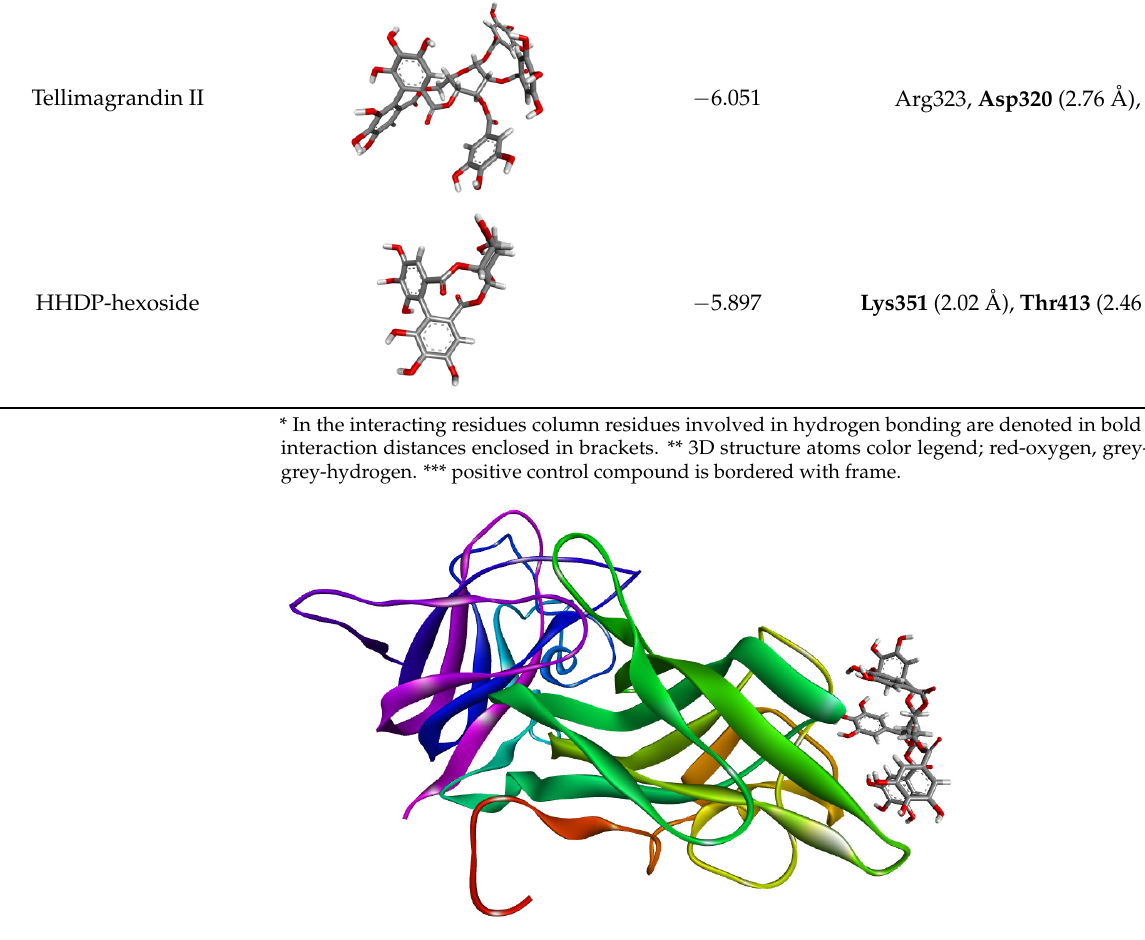
Figure 5. Pentagalloylglucose binding pose and site in complex with NRP1.